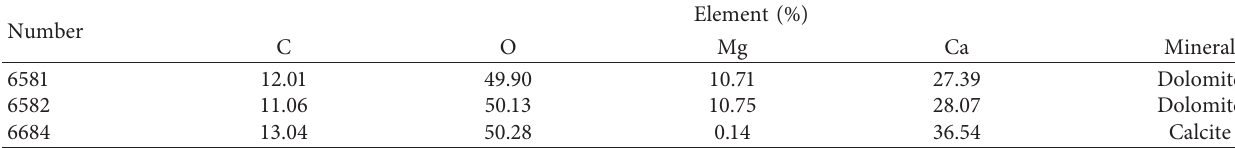
Table 6: Energy spectrum analysis results of dolomite and